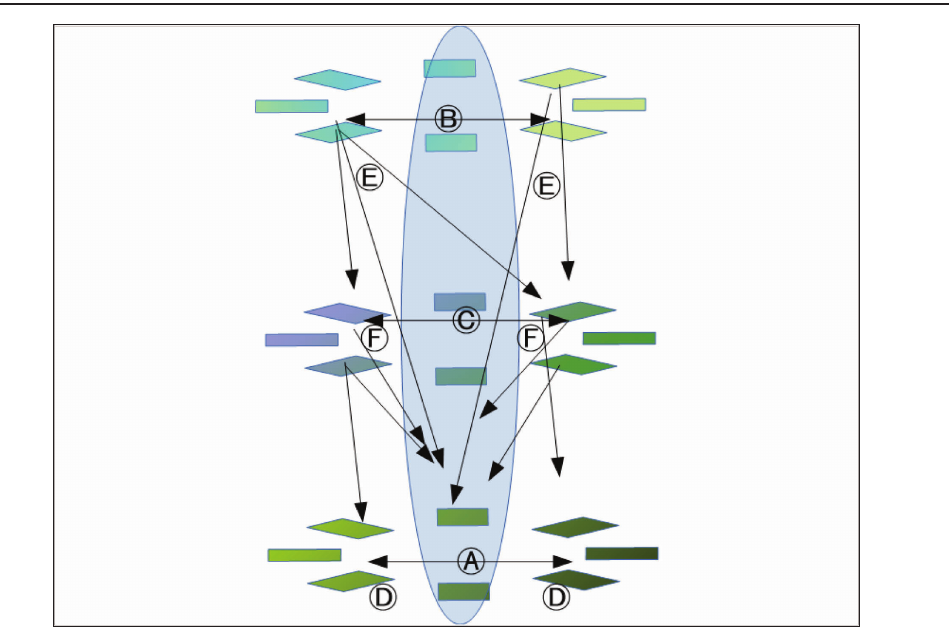
Figure 3: Dimensions of addressing perspective on intercultural